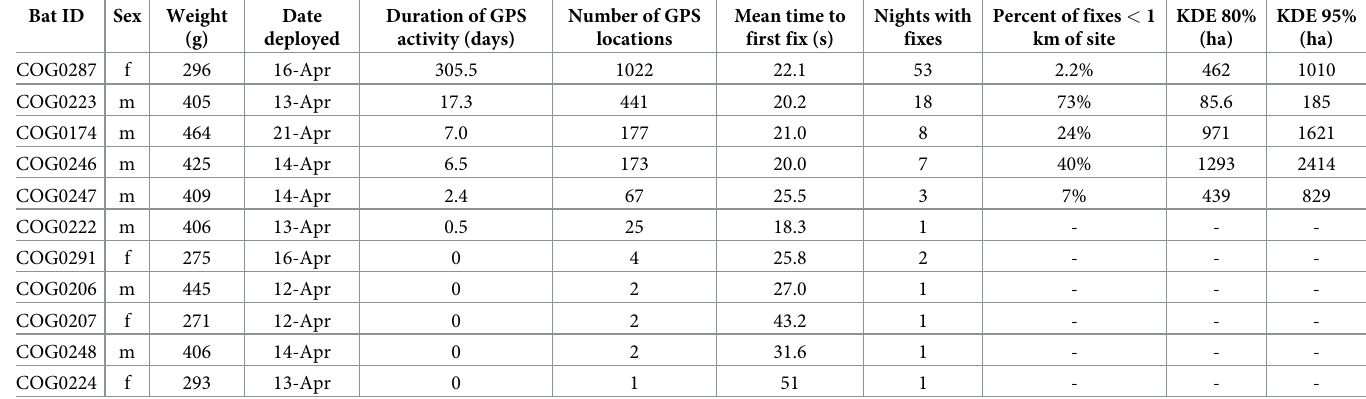
COG0223 respectively. Although the GPS tracking data for the fourth male (COG0247) does not show any re-visitation to the site, the base station at the lek site logged communications and incomplete download attempts with COG0247 on April 20, 25, 26, and 28. The female (COG0287) appeared to not visit the site for at least a period of 35 days from 21 April through 26 May, when 30 minute nightly GPS logging capability was lost due to low bat- tery power. With the decline of tag power, the tag’s base station communication remains func- tional, but the tag decreases the number of GPS fixes and eventually shuts off GPS. The lek base station downloads revealed she visited the site in 2018 on 12 June, 24 July, 30 July, and 24 August. Though her two initial visits were detected by GPS and not the base station, a rough estimate of mean site visitation frequency is 22 days with standard deviation 22 days. All data